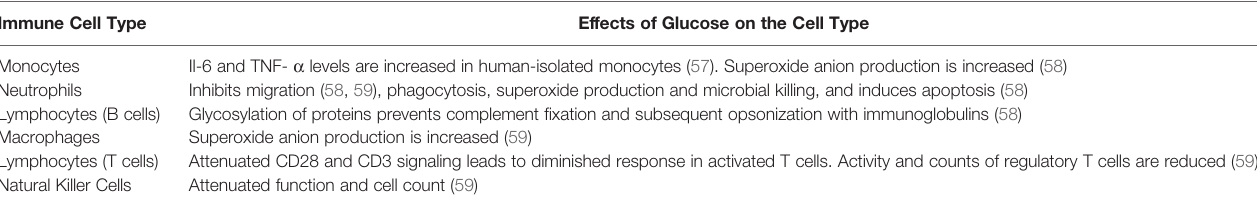
TABLE 1 | The effects of hyperglycemia on the various types of immune cells. Immune Cell Type Effects of Glucose on the Cell Type